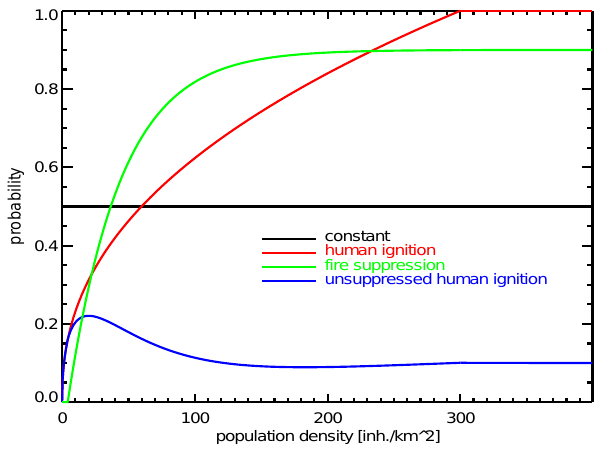
Fig. A1. Human ignition probability and fire suppression [0–1] as function of population density [inhabitants / km 2 ]. Black: constant ignition probability; red: Human ignition probability; green: fire suppression; blue: unsuppressed human ignition (human ignition ∗ (1 − fire suppression)).